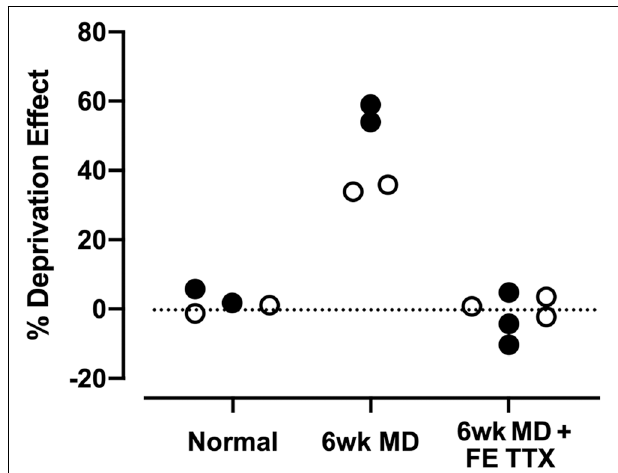
FIGURE 1 | Summary of data from Duffy et al. (2018) that examined the recovery of neuron soma size (open circles) and neurofilament labeling (closed circles) in the lateral geniculate nucleus of monocularly deprived cats. Six weeks of monocular deprivation (MD) started at the peak of the critical period for plasticity produced a large deprivation effect with deprived neurons rendered about ∼ 35% smaller than neurons connected to the non-deprived eye, and deprived layers showing a ∼ 55% reduction in the density of neurofilament-positive neurons. Inactivation of the fellow eye for 10 days with intravitreal administration of tetrodotoxin (TTX; FE TTX) promoted a full recovery of neuron soma size and neurofilament-positive cell density in originally deprived-eye layers of the lateral geniculate